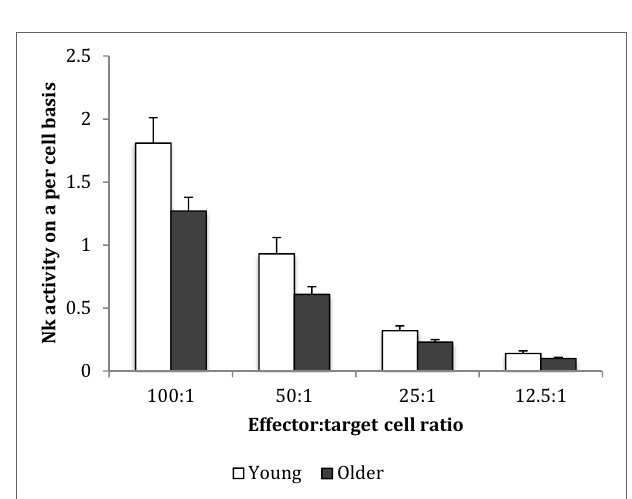
FiGUrE 3 | Baseline natural killer cell activity on a per cell basis. Data are mean ± SEM at week 0, for n = 54 subjects per group. Data were analyzed using independent samples t -test (2-tailed). P = 0.02 for E/T ratio 100:1, P = 0.03 for 50:1, P = 0.038 for 25:1, and P = 0.116 for 12.5:1.